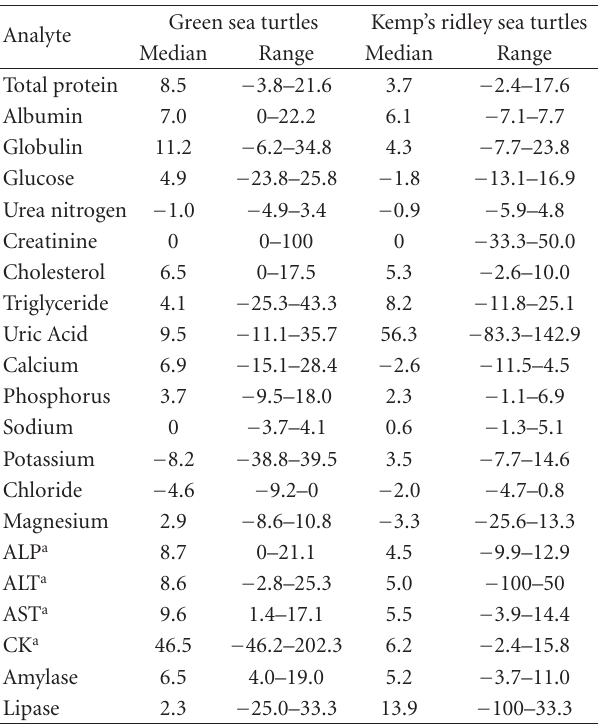
Table 4: Median % di ff erences and ranges between postprandial and preprandial plasma biochemical values from juvenile green ( n = 10) and Kemp’s ridley ( n = 10) sea